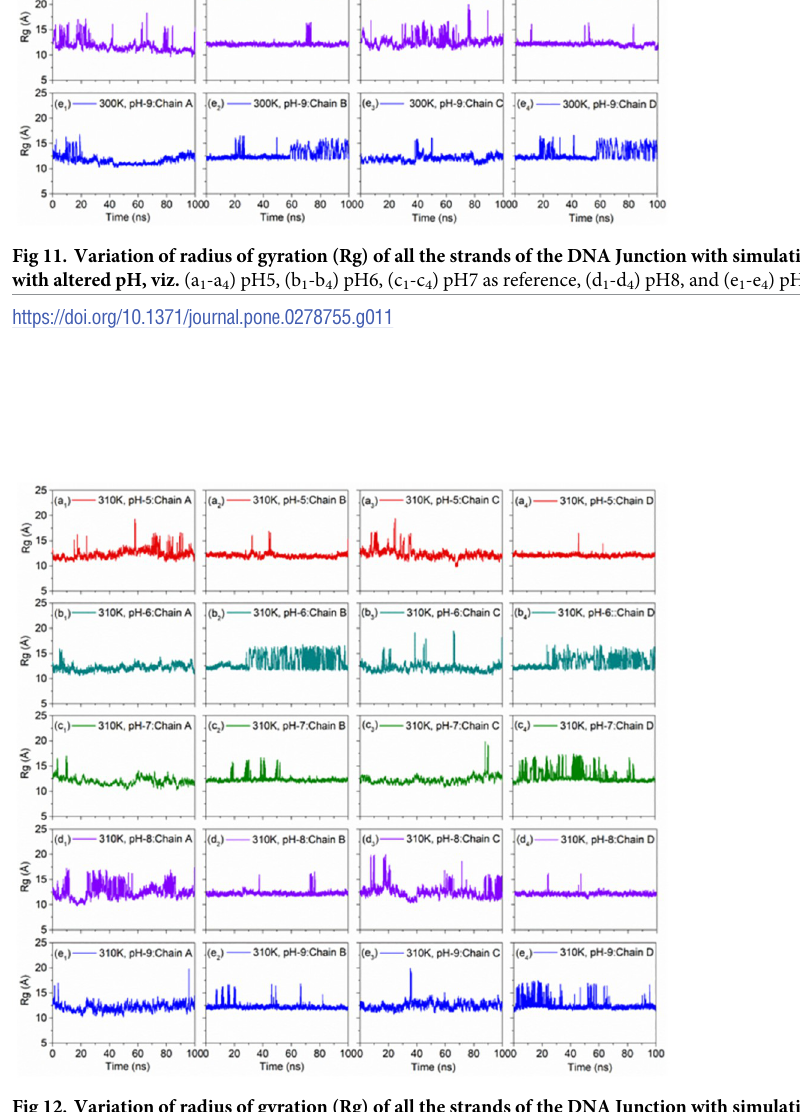
PLOS ONE | https://doi.org/10.1371/journal.pone.0278755 February 8, 2023 17 /